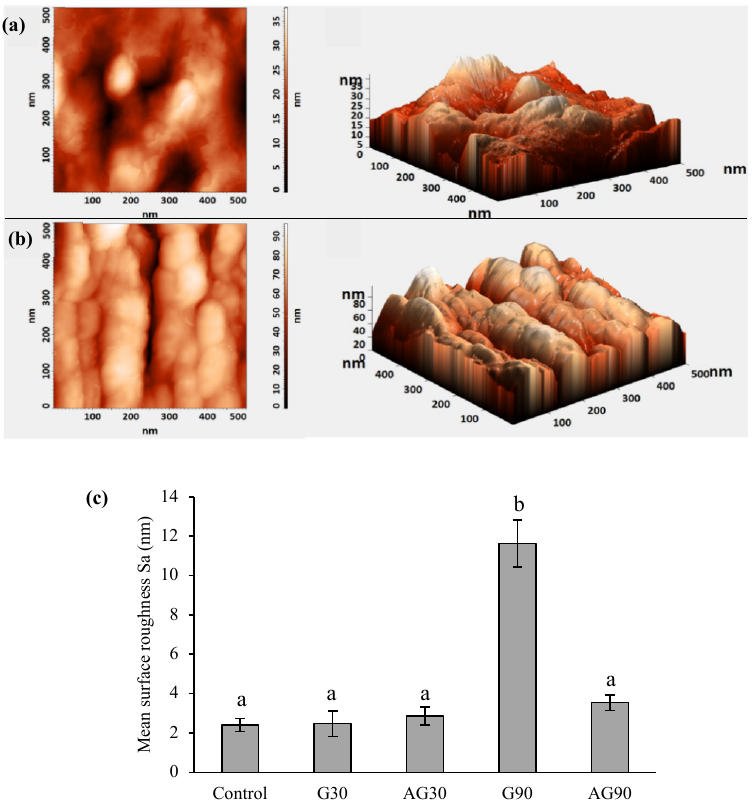
Figure 3. AFM height and 3D image of seed coat surface of untreated seeds ( a ) and CP-treated seeds in the glow regime for 90 s (G90) ( b ). Mean surface roughness (Sa) of seeds treated in glow regime for 30 (G30) or 90 s (G90), and afterglow regime for 30 (AG30) or 90 s (AG90) ( c ). Displayed values are the mean ± SE of three replications. Different letters (a, b) indicate statistically significant differences among treatments according to Duncan’s test ( p <